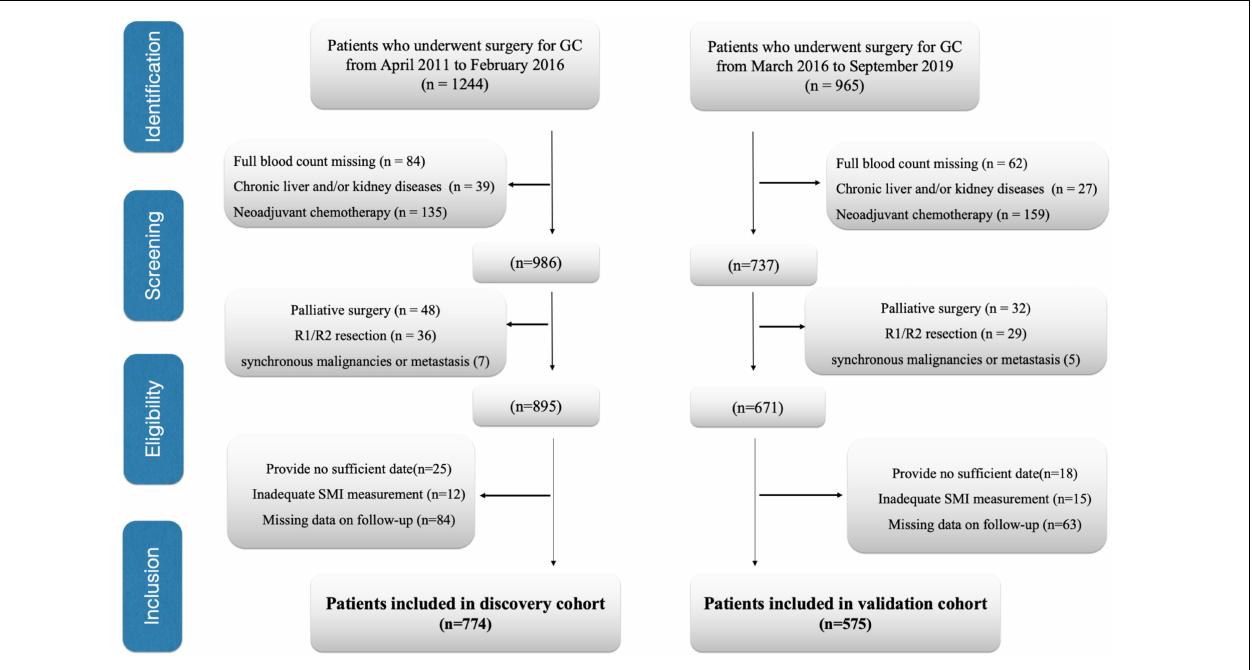
FIGURE 1 | Flow diagram of patients. GC, gastric cancer; SMI, skeletal muscle